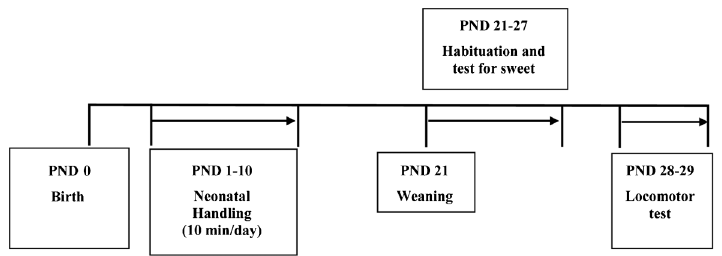
Figure 1. Scheme for the first set (locomotor test) of behavioral tasks in separated and non-separated dams on postnatal days 28 to 29, for n = 8-9